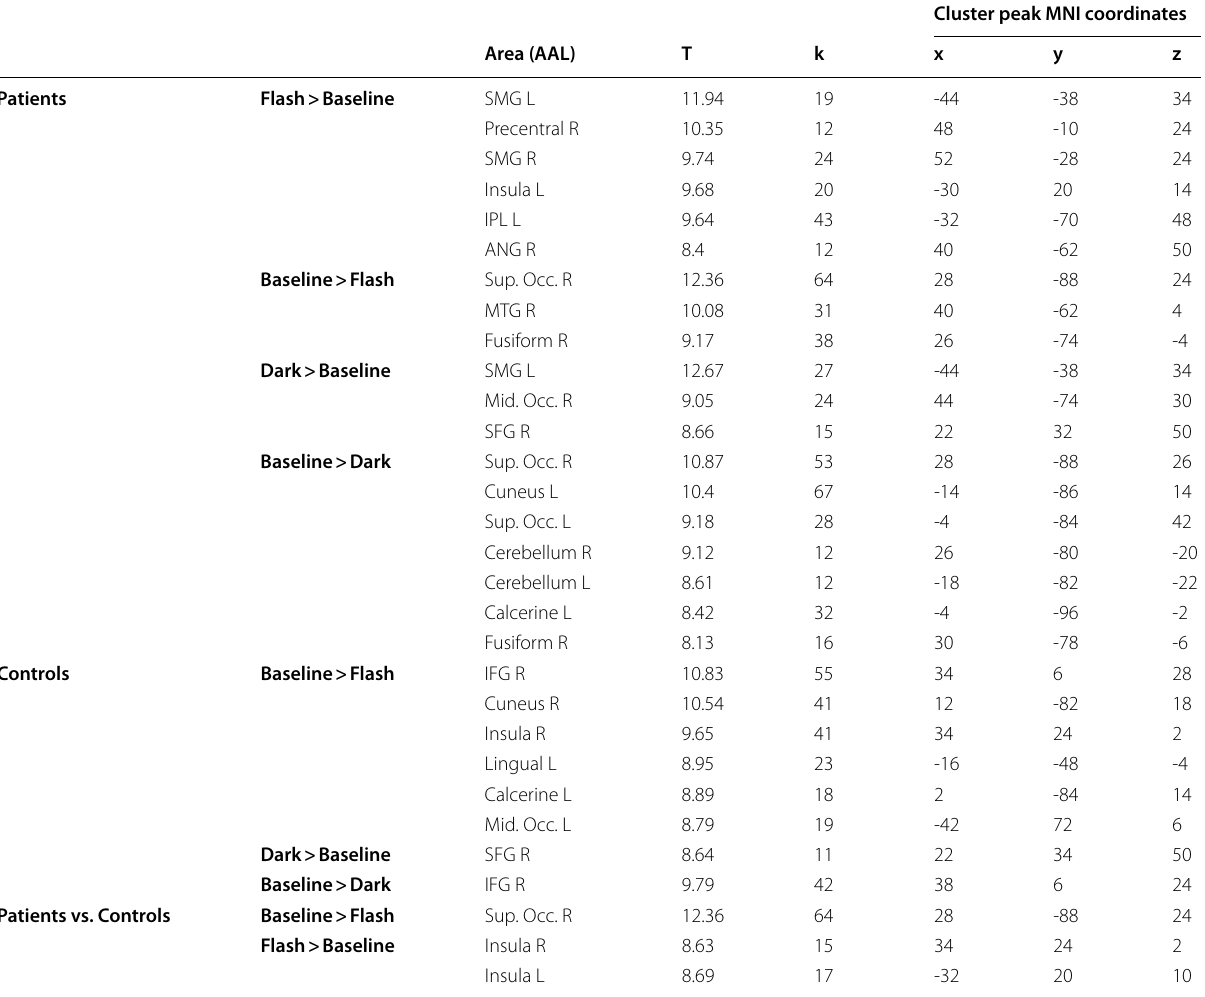
Table 3 Significant light-induced activation relative to the baseline (FWE 0.05, k